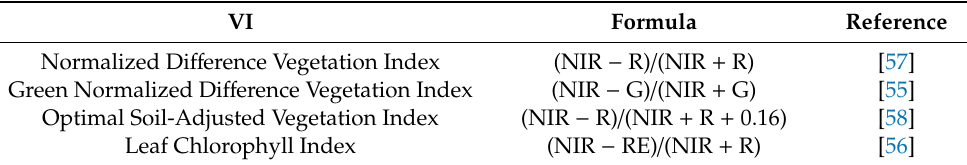
Table 3. Four vegetation indices (VIs) used for the research.